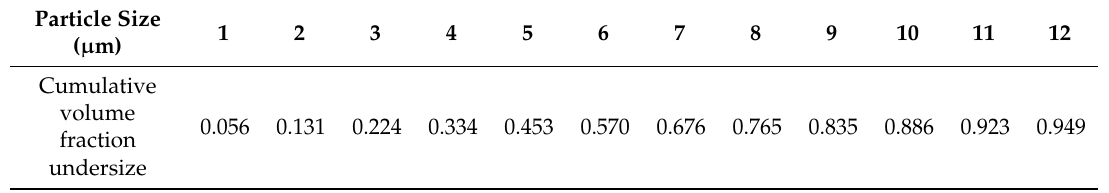
Table 1. Particle size distribution for the Computational Fluid Dynamics (CFD)